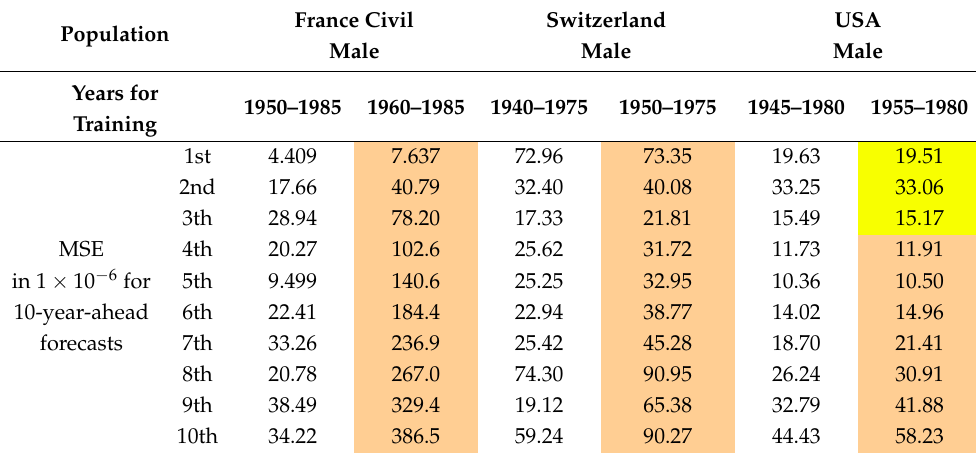
Table 11. DLGC 10-year-ahead forecasts’ accuracy in males as controls to Table 10.